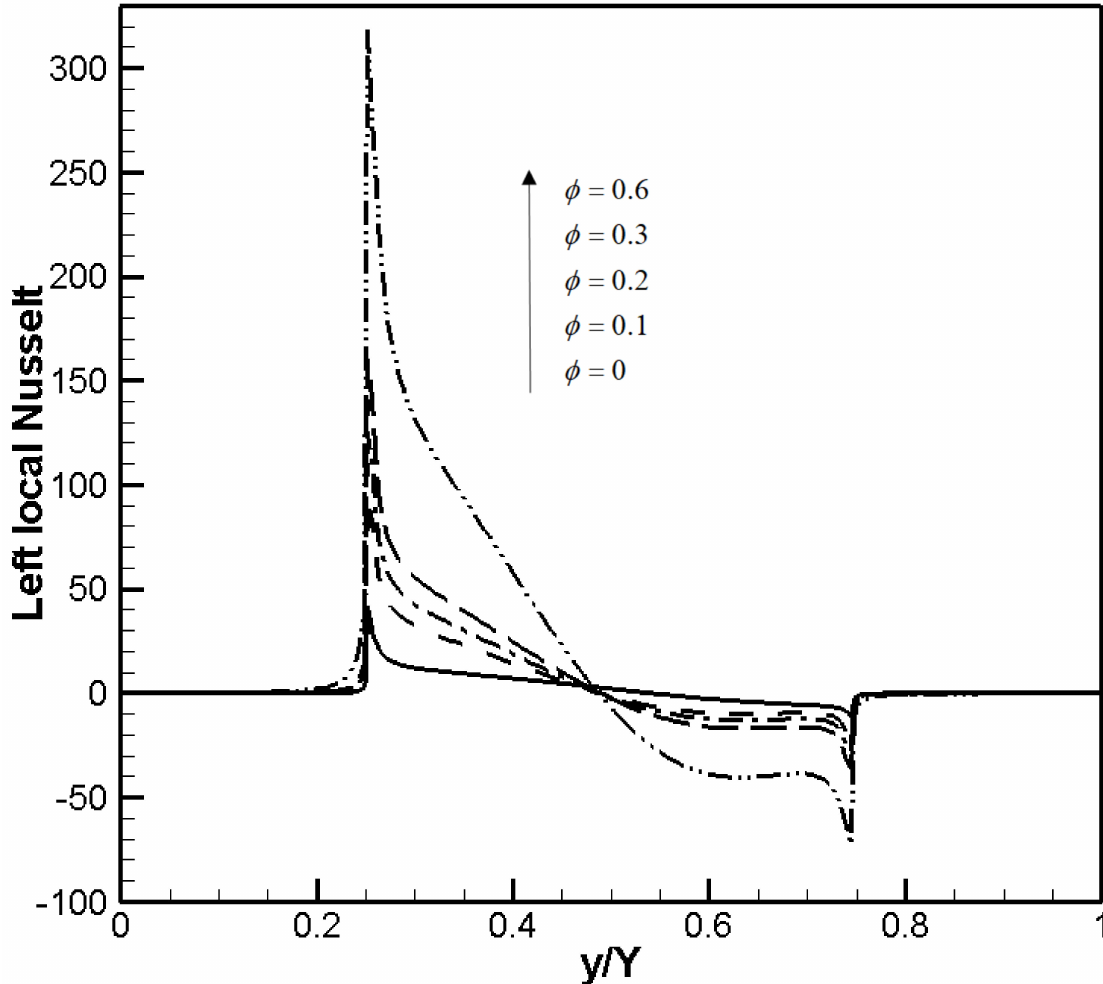
Figure 14. Variation of left local Nusselt number along the left boundary (Cu-water nanofluid) for different volume fractions ( φ ) (case 3: Sinusoidal boundary condition) at Ra = 10 5